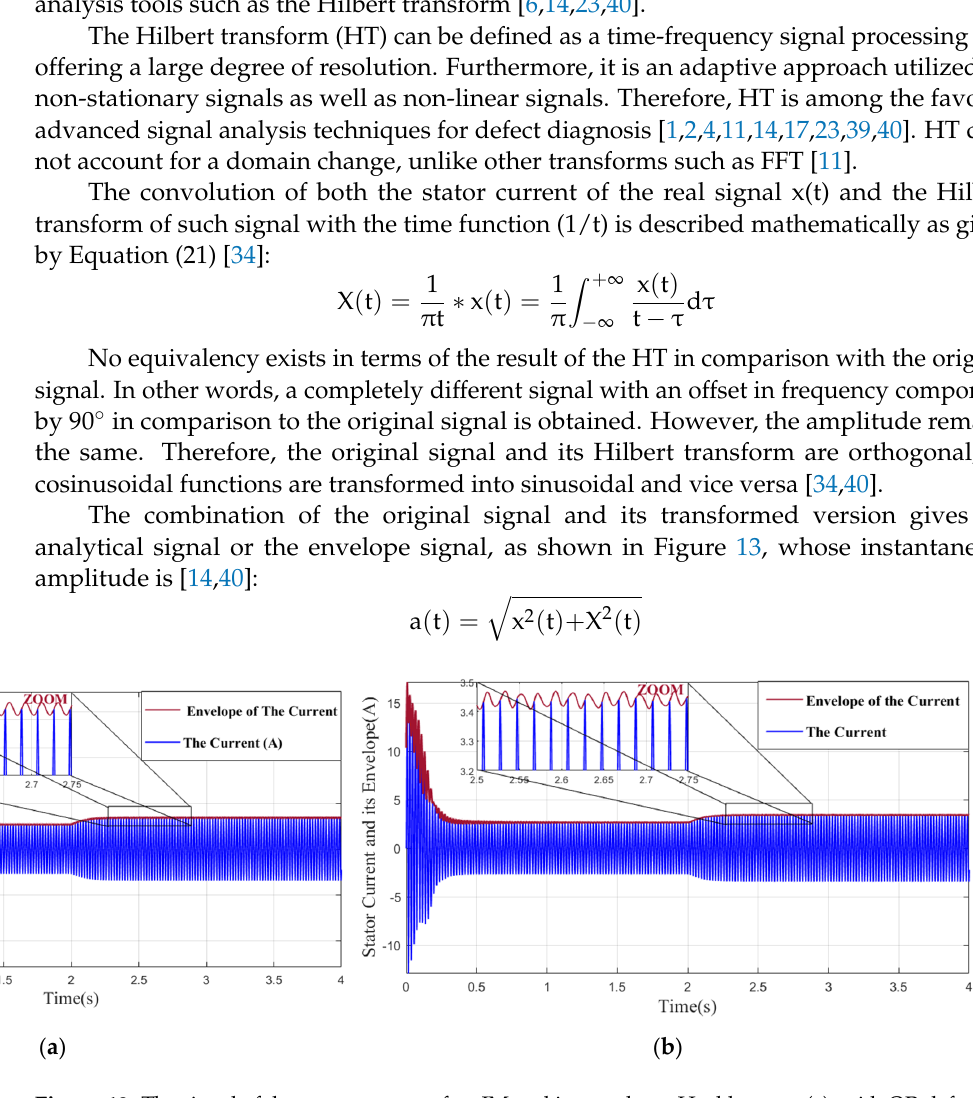
Figure 13. The signal of the stator current of an IM and its envelope. Healthy state ( a ); with OR defect ( b ).